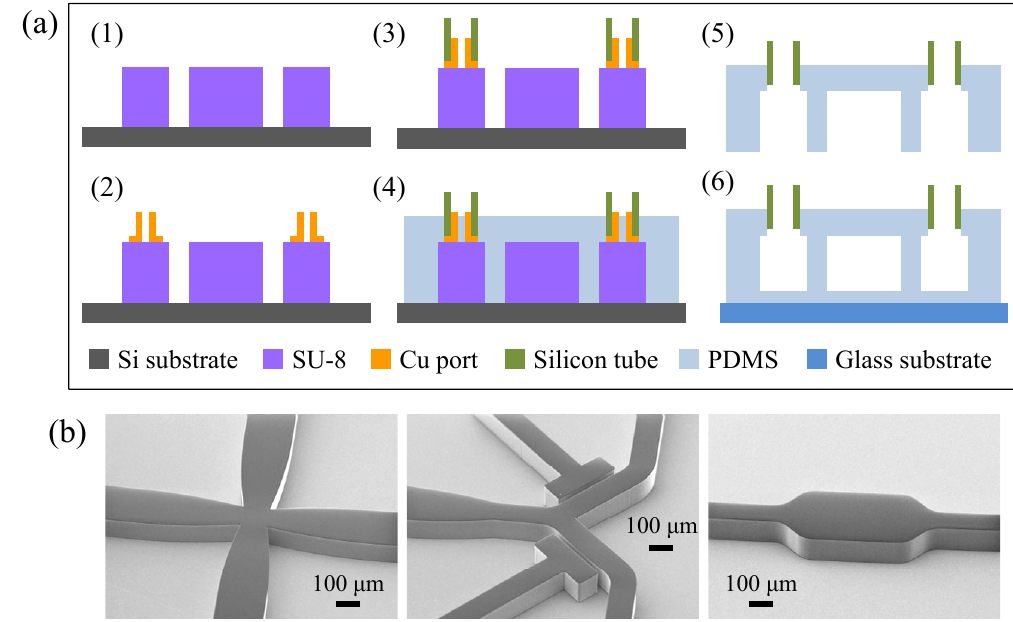
Figure 4. ( a ) Fabrication process of the droplet division device. ( b ) SEM images of the SU-8 mold of each